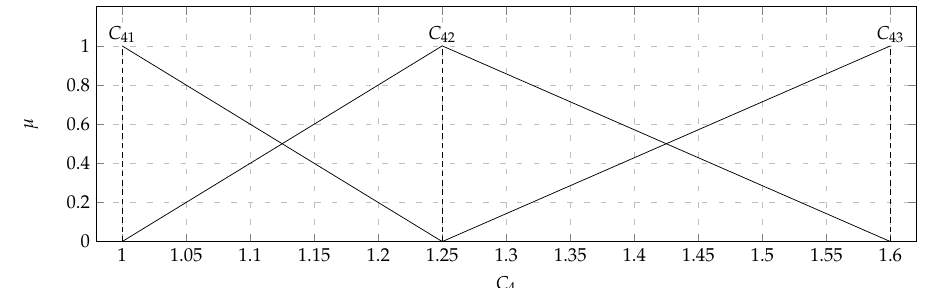
Figure 8. Visualization of Total kills ( C 3 ) and triangular fuzzy numbers 0.0 ( C 31 ), 0.5 ( x 32 ), and 1.0 ( x 33 ).